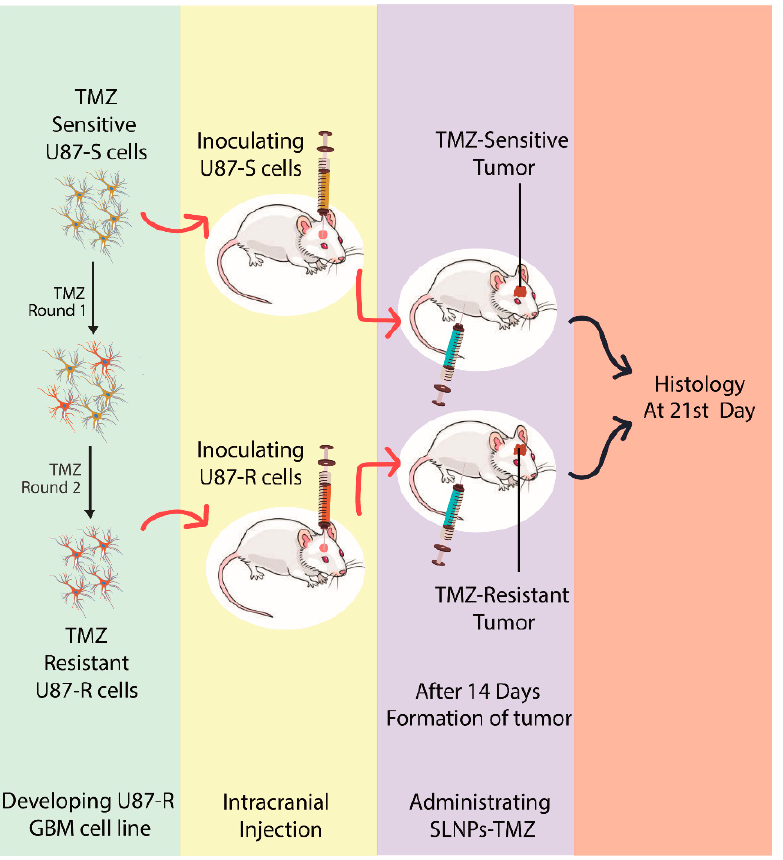
Figure 3. Graphical representation of intracranial inoculation of glioma using U87-S and U87-R and its treatment with SLNPs-TMZ and free TMZ.